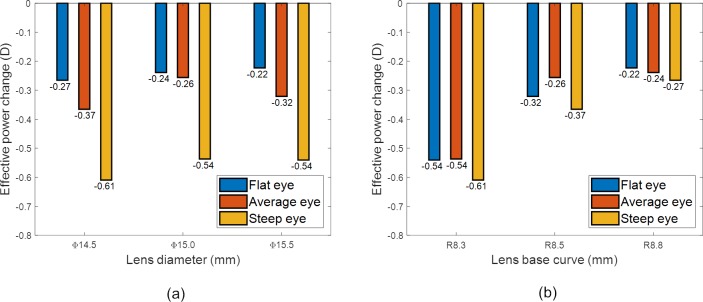
Parametric analysis of spherical prescriptions, (a) effect of lens diameter, (b) effect of the lens base curve.